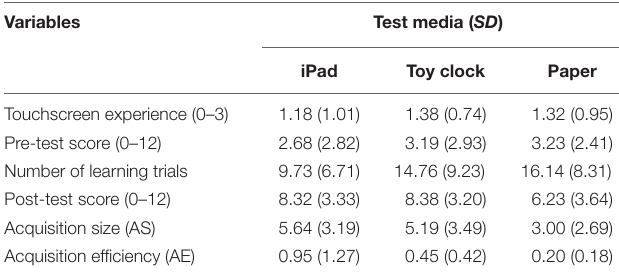
TABLE 1 | Means and standard deviations as a function of test